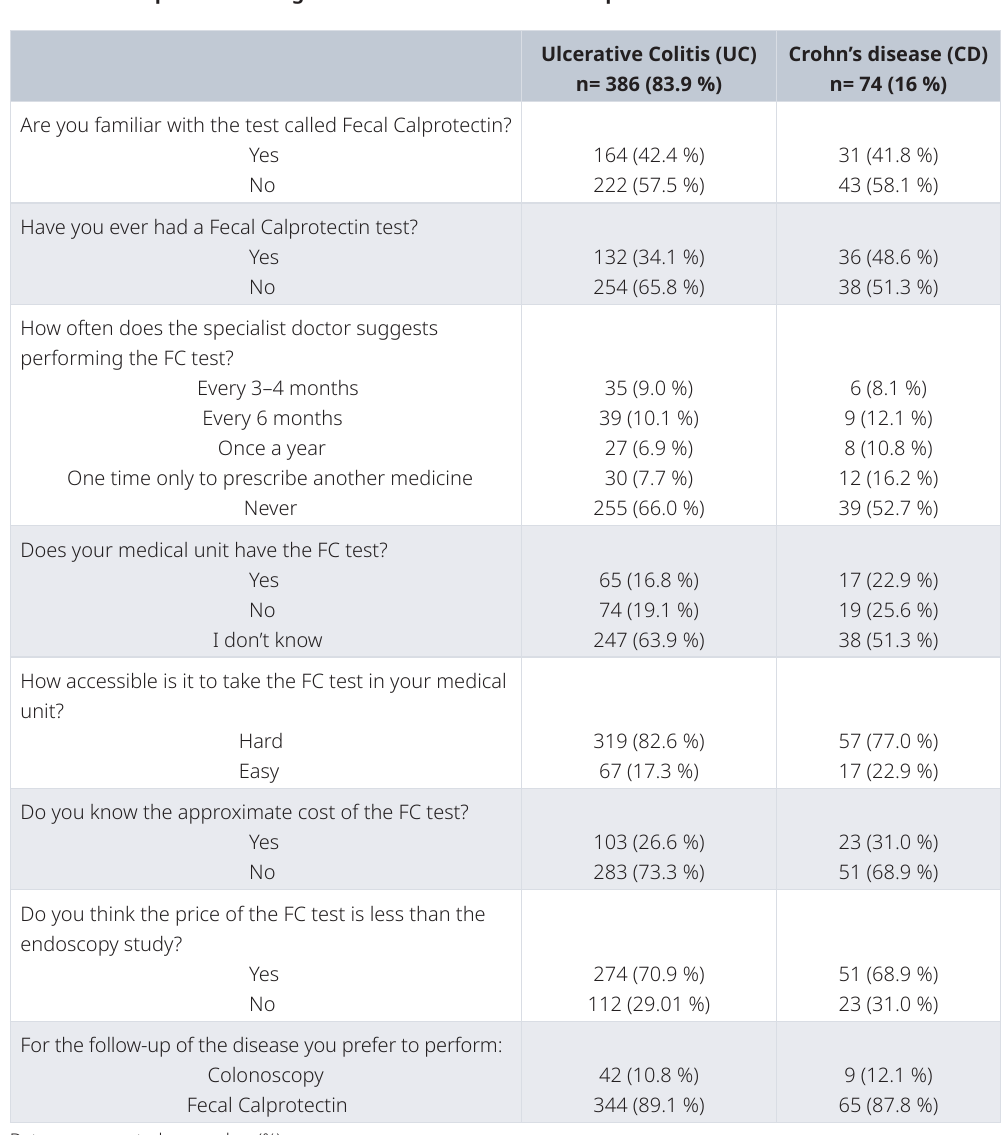
Table 3. Participant knowledge of the non-invasive Fecal Calprotectin